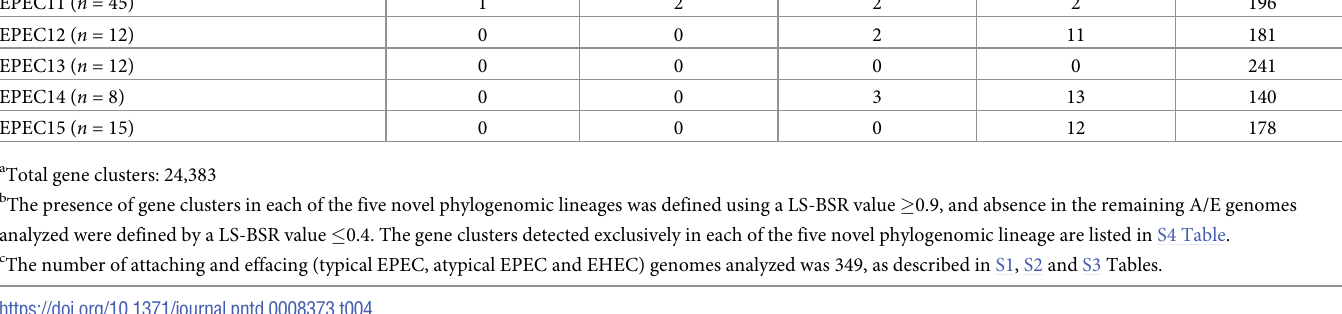
Table 4. Detection of gene clusters that are unique to each of the novel EPEC phylogenomic lineages. Phylogenomic Lineages (number of genomes) c